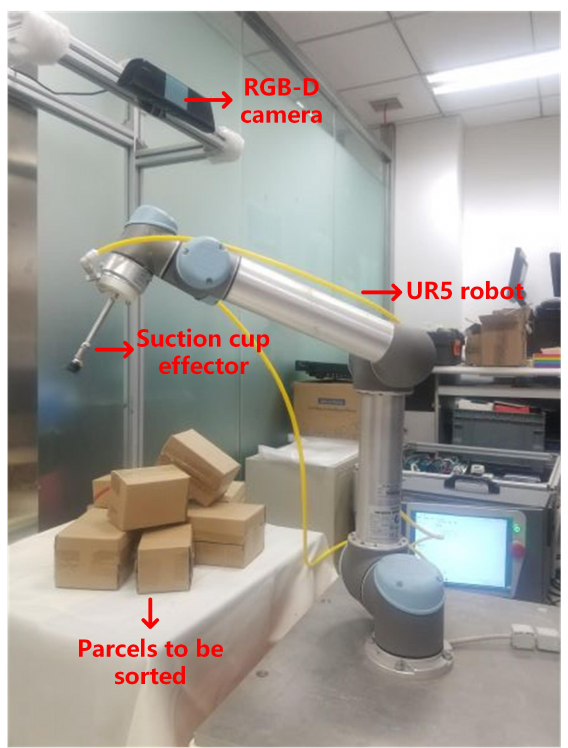
Figure 8. Vision-based robot sorting experiment platform.